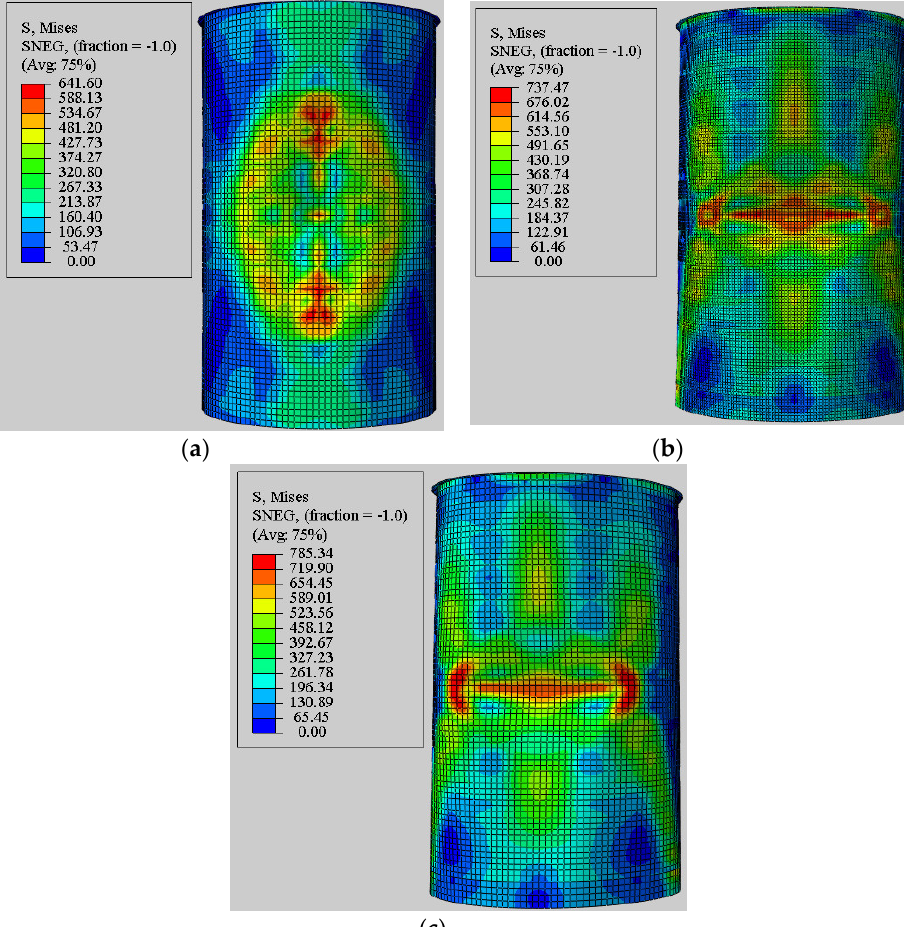
Figure 13. Deformed shape with different indenter surfaces: ( a ) hemispherical indenter; ( b ) knife-edge indenter; and ( c ) rectangular indenter.